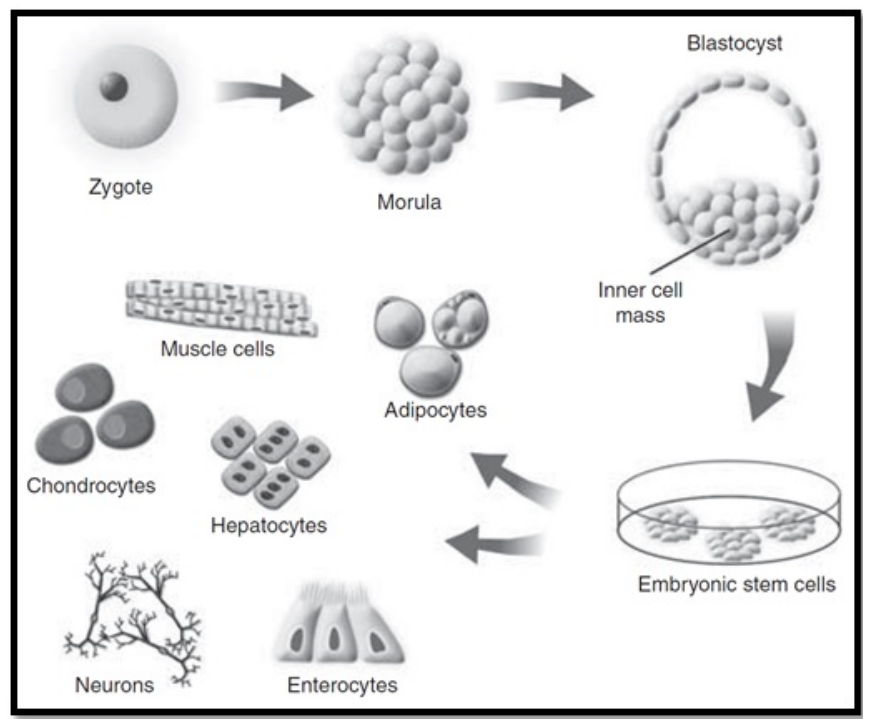
Figure 5. Embryonic stem cell cultivation [78] .